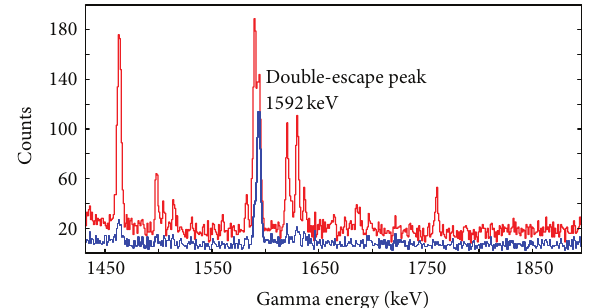
Figure 3: Pulse-shape analysis results for P-PC data. The red spec- trum is for all events within the energy range, while the blue spec- trum is for events that pass the PSA